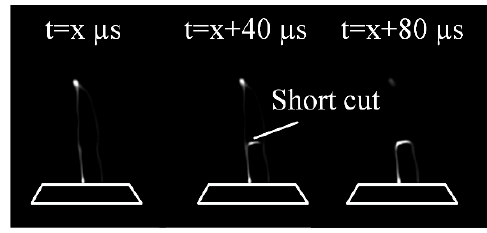
Figure 7. Short-cutting of the gliding arc.